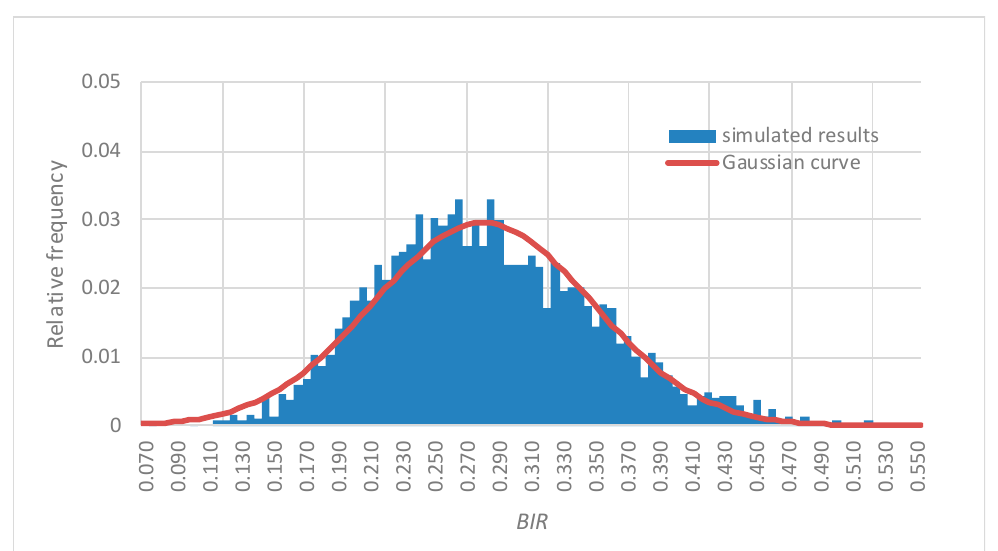
Figure 1. Comparison between simulated and analytical relative frequency curves.